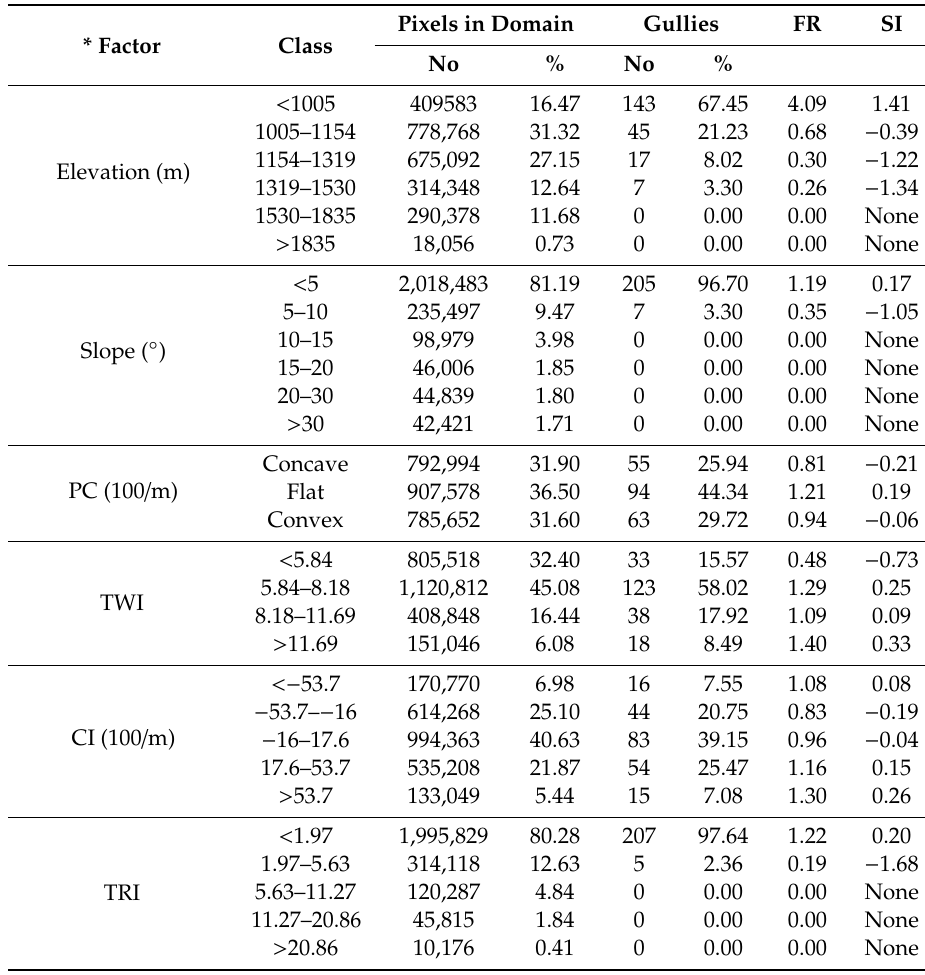
Table 3. Spatial relationship between conditioning factors and gully locations using frequency ratio and statistical